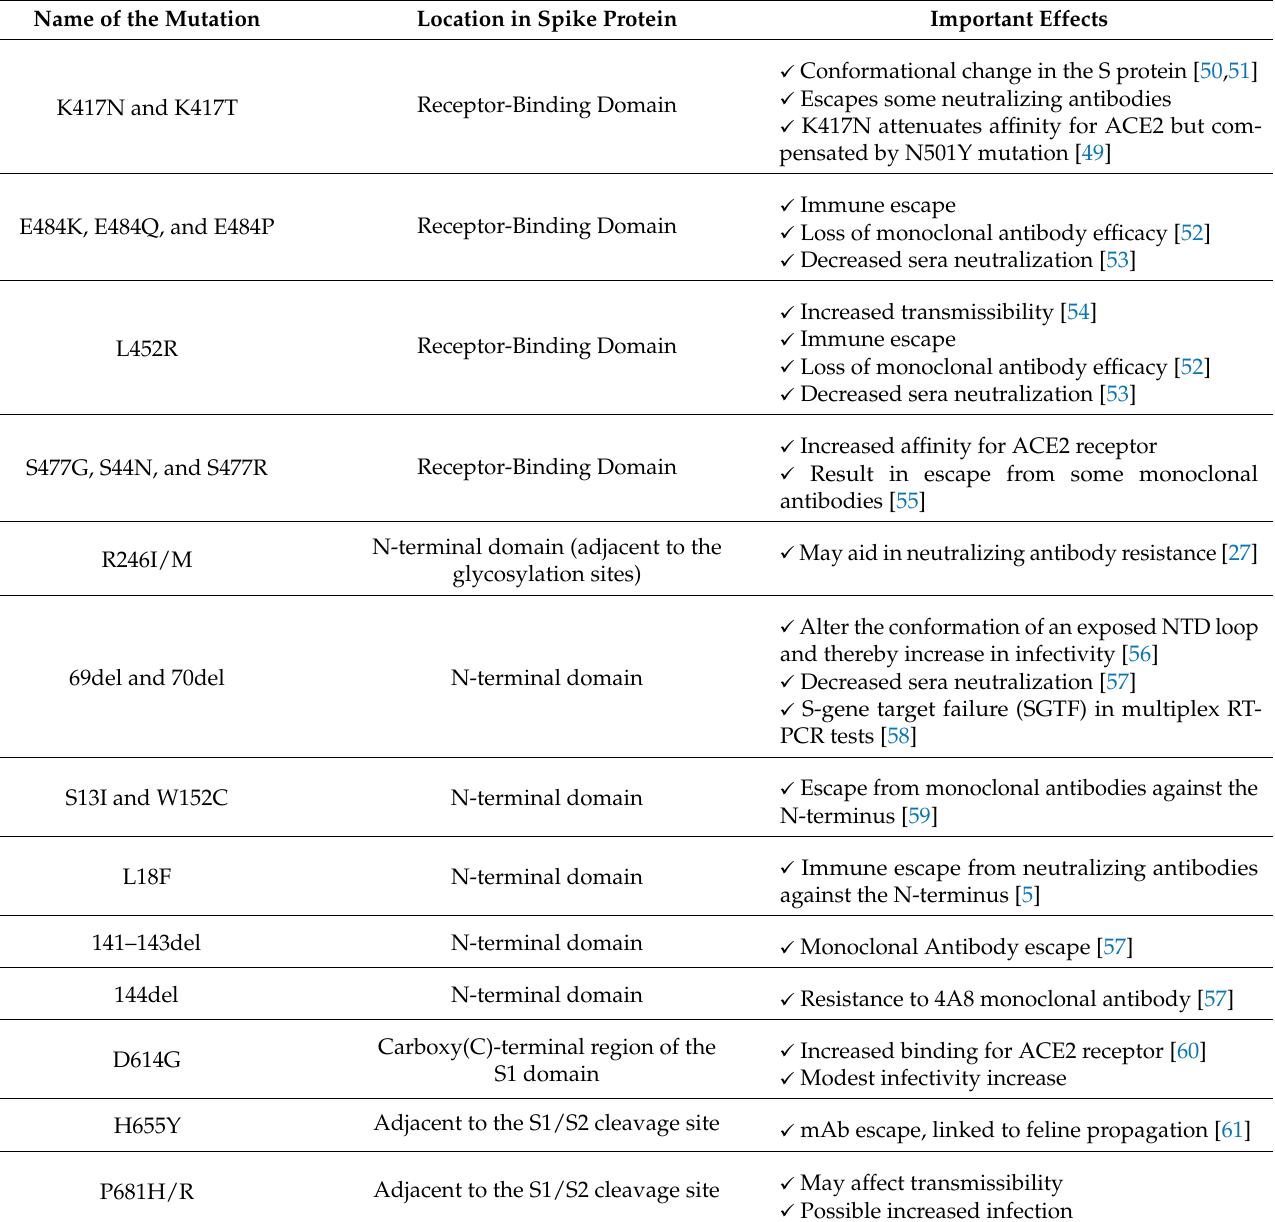
Table 2. Cont. Table 2. Predominant Spike Mutations associated with SARS-CoV-2 variants. Table 2. Predominant Spike Mutations associated with SARS-CoV-2 variants. Table 2. Predominant Spike Mutations associated with SARS-CoV-2 variants.